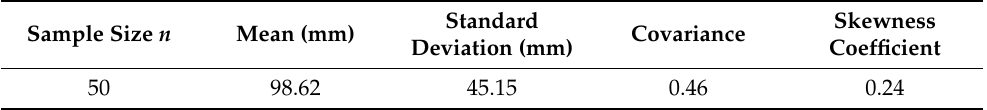
Table 1. Statistical variables of the annual maximum 24 h rainfall dataset.